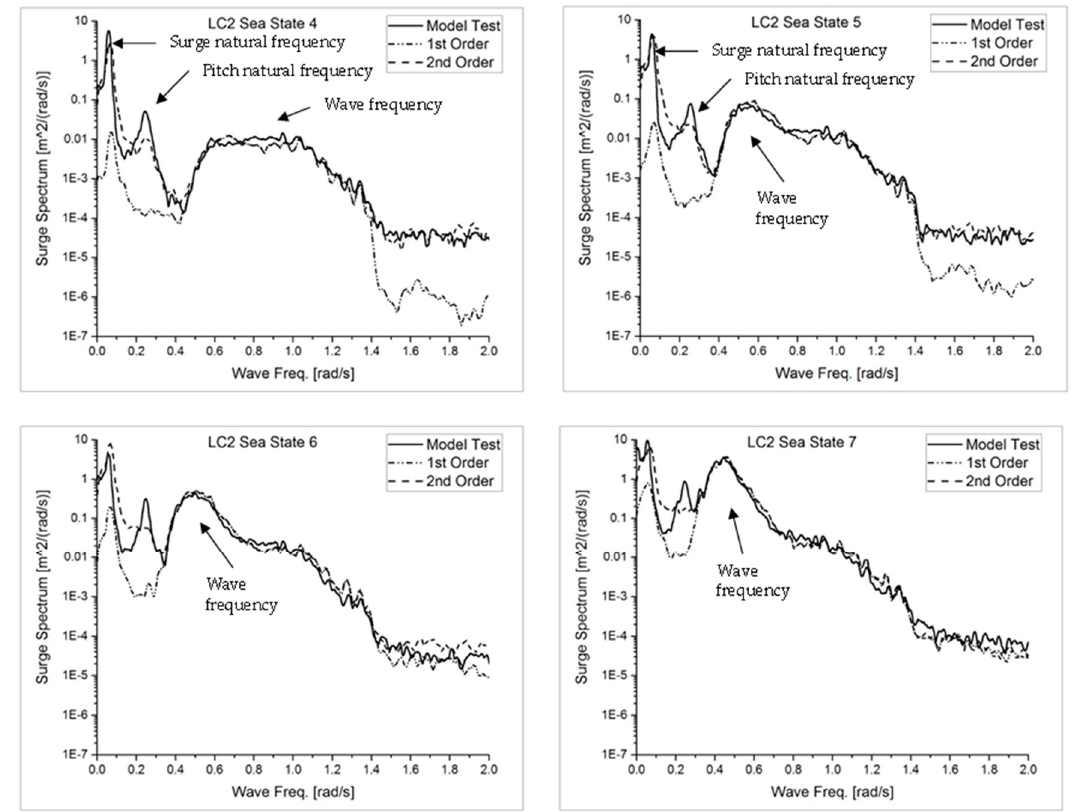
Figure 11. Surge spectrums of four sea states in LC2 (irregular waves, operational wind turbine with rated thrust force).